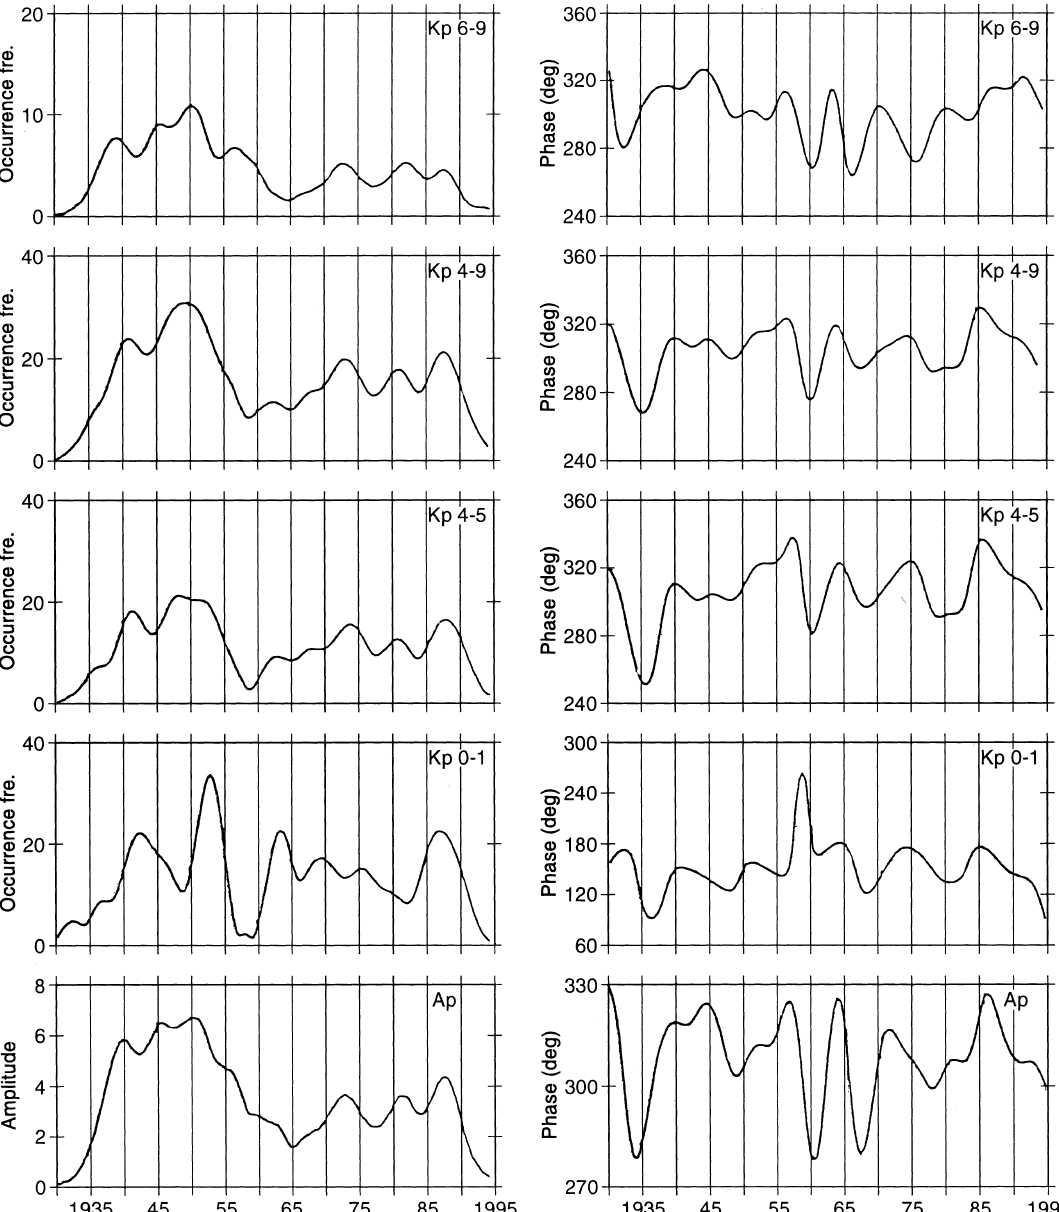
Fig. 6. Time local changes in the amplitude and phase of the semiannual component in Ap and occurrence frequencies of di(cid:128)erent categories of Kp, derived from complex demodulation of the